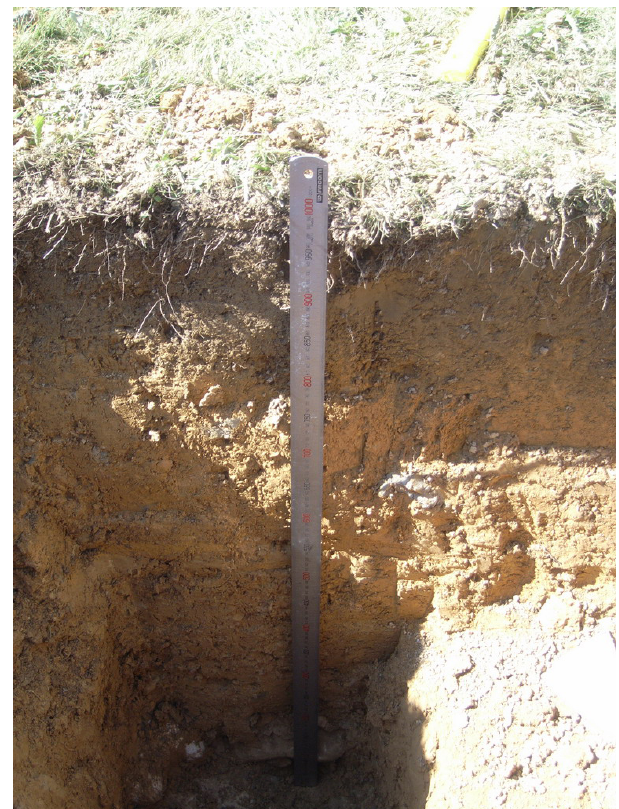
Figure 4. Soil profile of 1m depth performed close to location 33 (Fig. 2) on 29 September 2008. The visual characterization provided in Table 1 can be seen on this